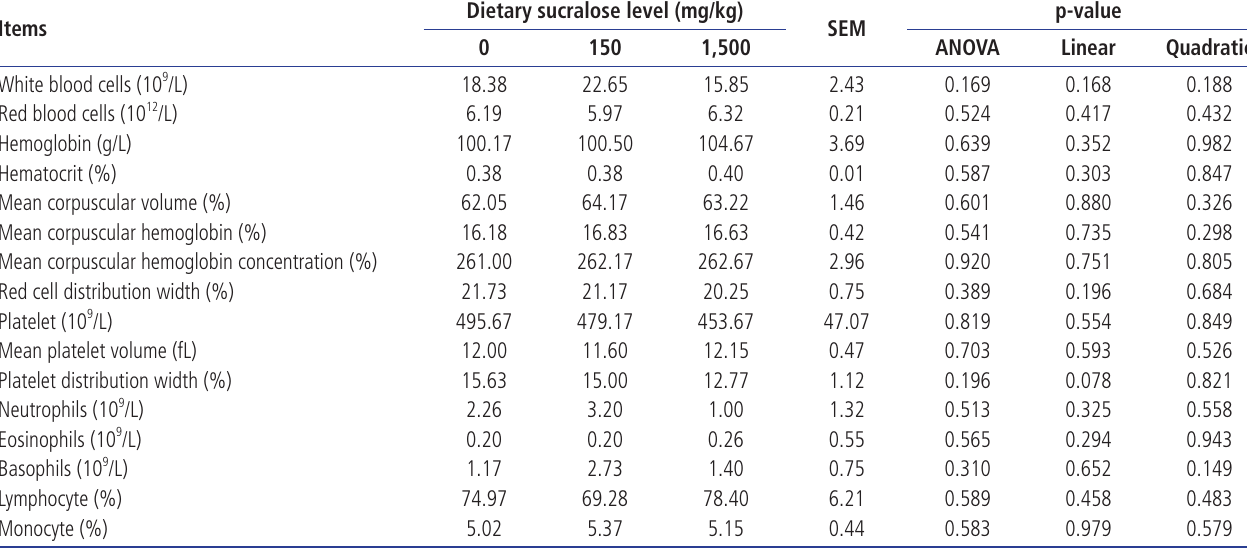
Table 5. The effects of graded levels of sucralose on hematological parameters of weaned piglets (experiment 3)